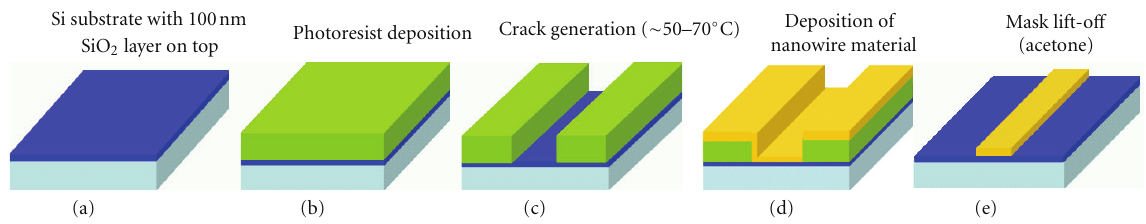
Figure 3: Schematic processes (a) to (e) involved in fabricating the nanowires by thin film fracture approach